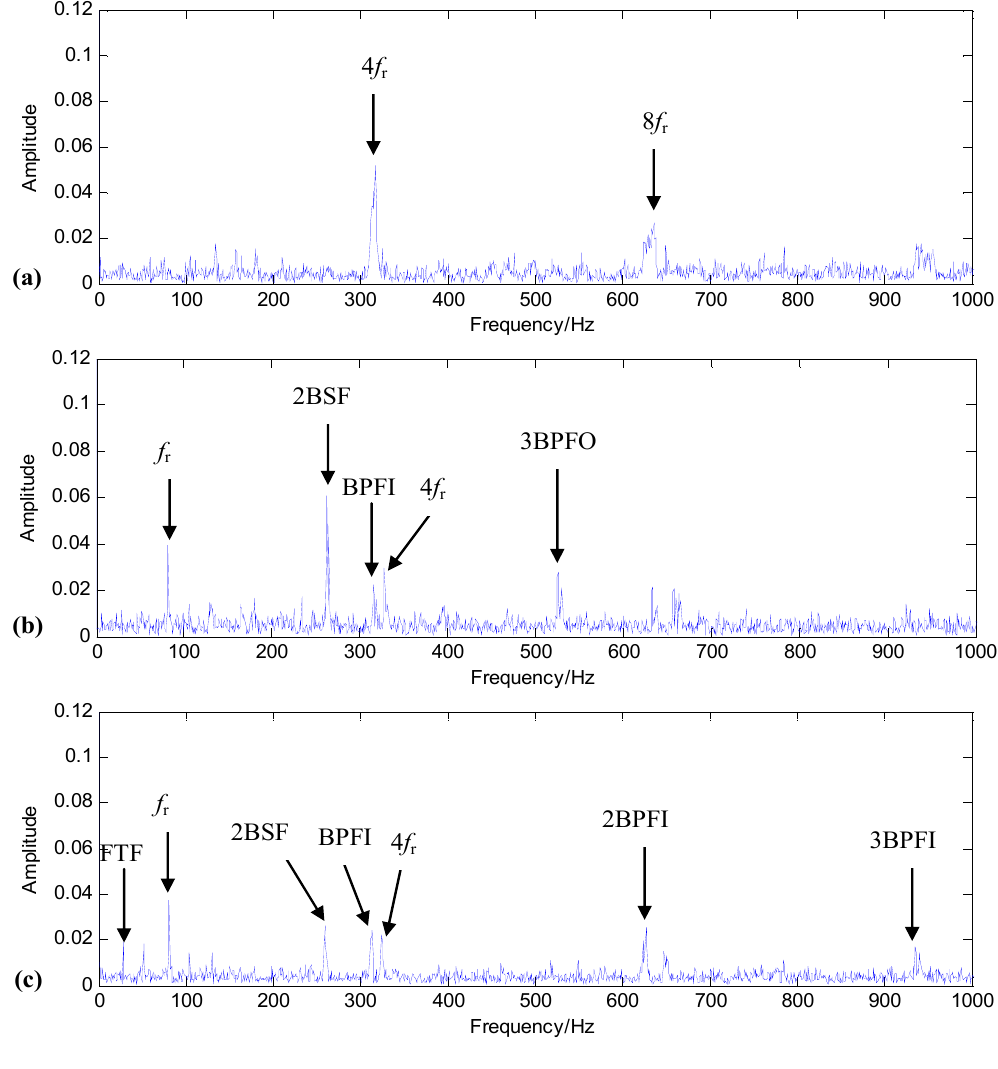
Figure 8. The spectral analysis of vibration data files: ( a ) the spectrum of data file 97; ( b ) the spectrum of data file 98; ( c ) the spectrum of data file